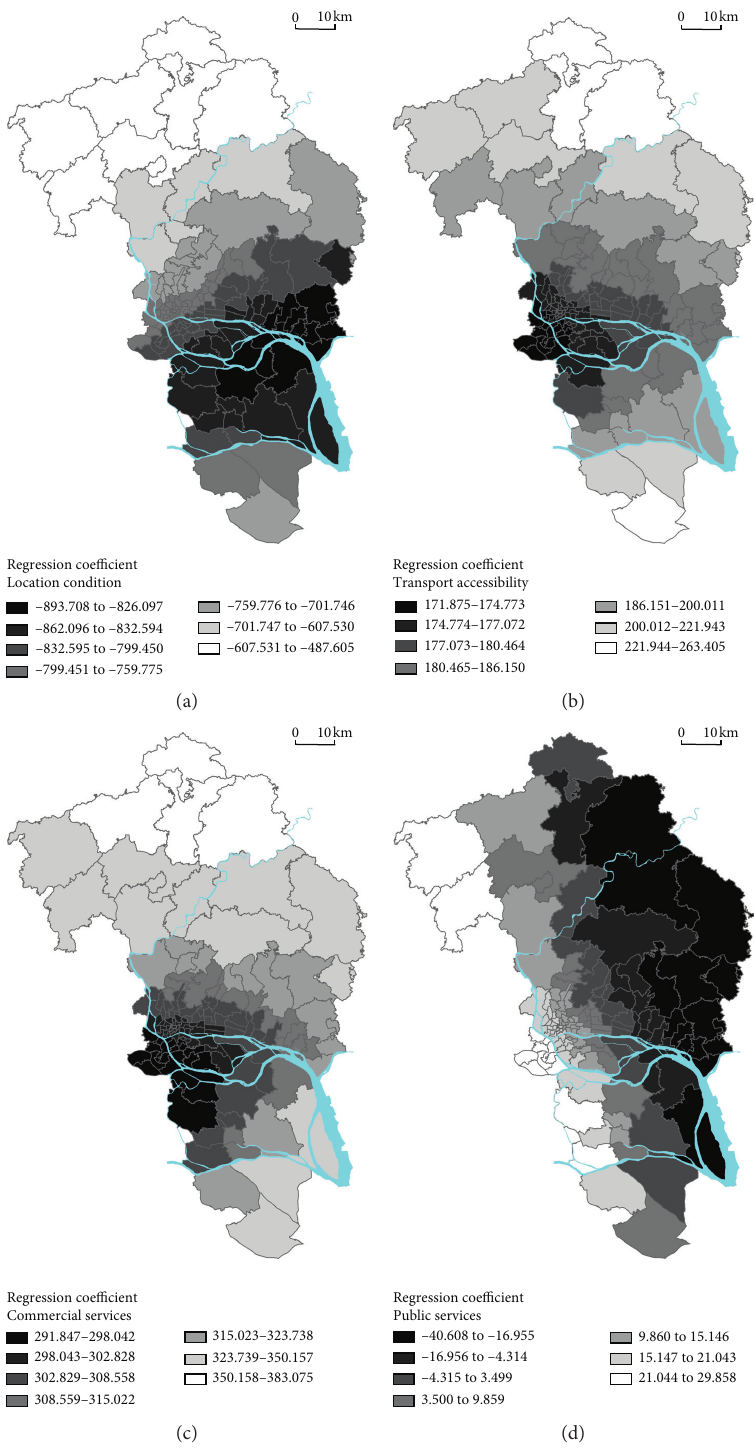
Figure 10: Spatial differences of geographically weighted regression coefficients. (a) K D